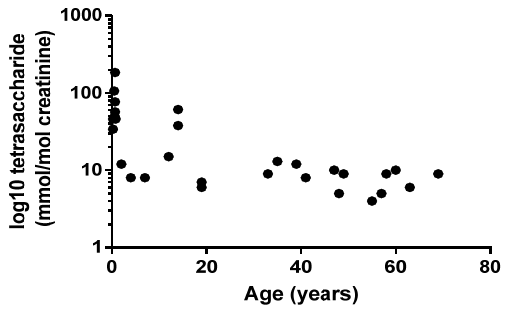
Figure 3. Relationship between patient age at diagnosis and urine tetrasaccharide concentrations. Pearson’s r = − 0.543; p = 0.002.